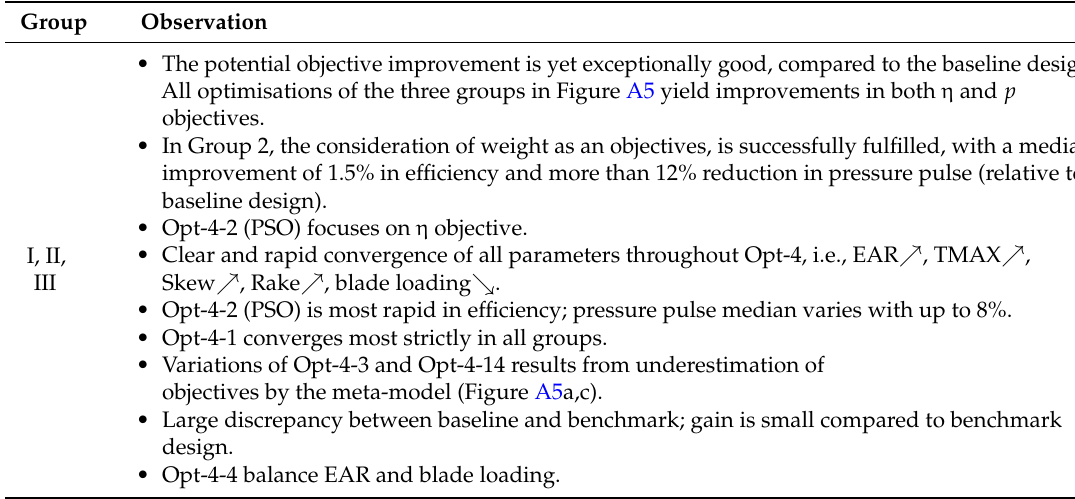
Figure 15. Development of K T ( a ) and FEM constraints ( b ) in Group 3. Table 9. Potential improvement and convergence observations of